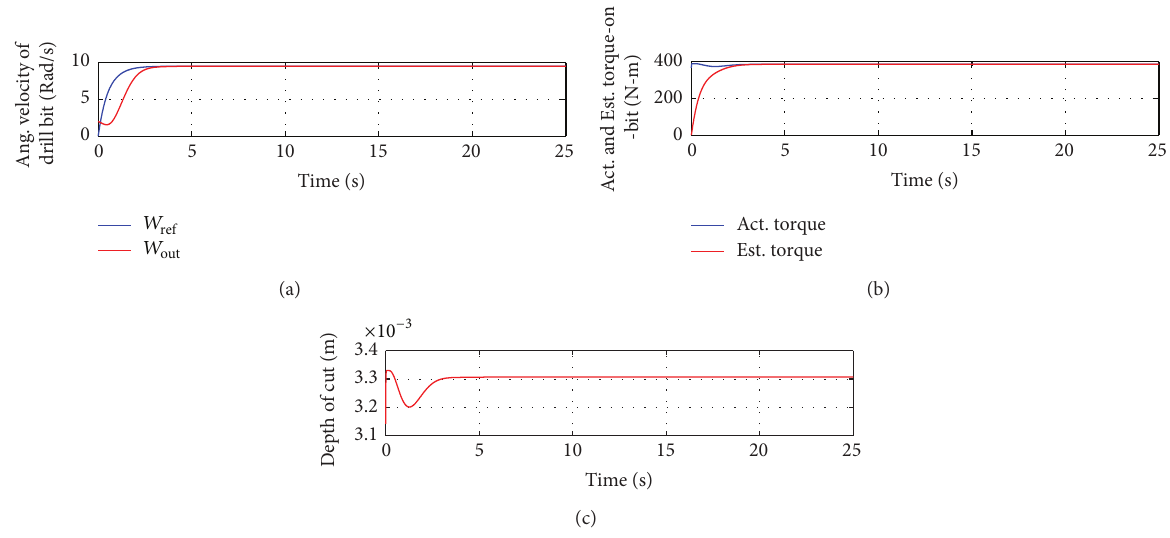
̂𝑇(𝑡) (b), and the depth of cut 𝑑(𝑡) (c)